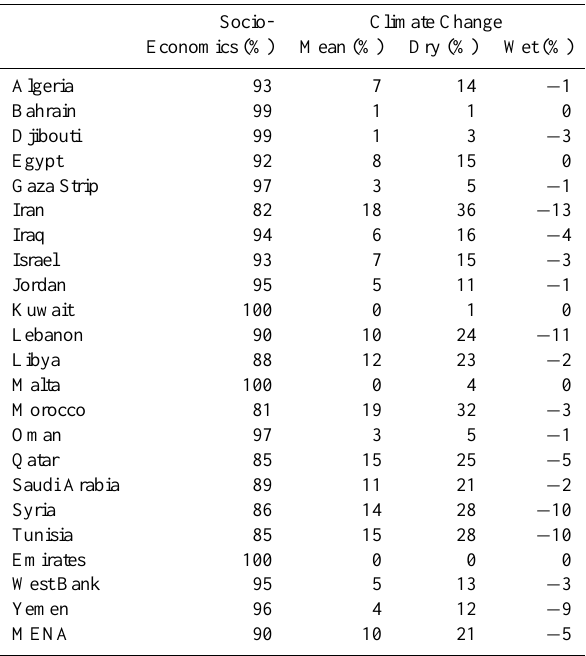
Table 4. Contribution of socio-economic changes and climate changes on total water demand in